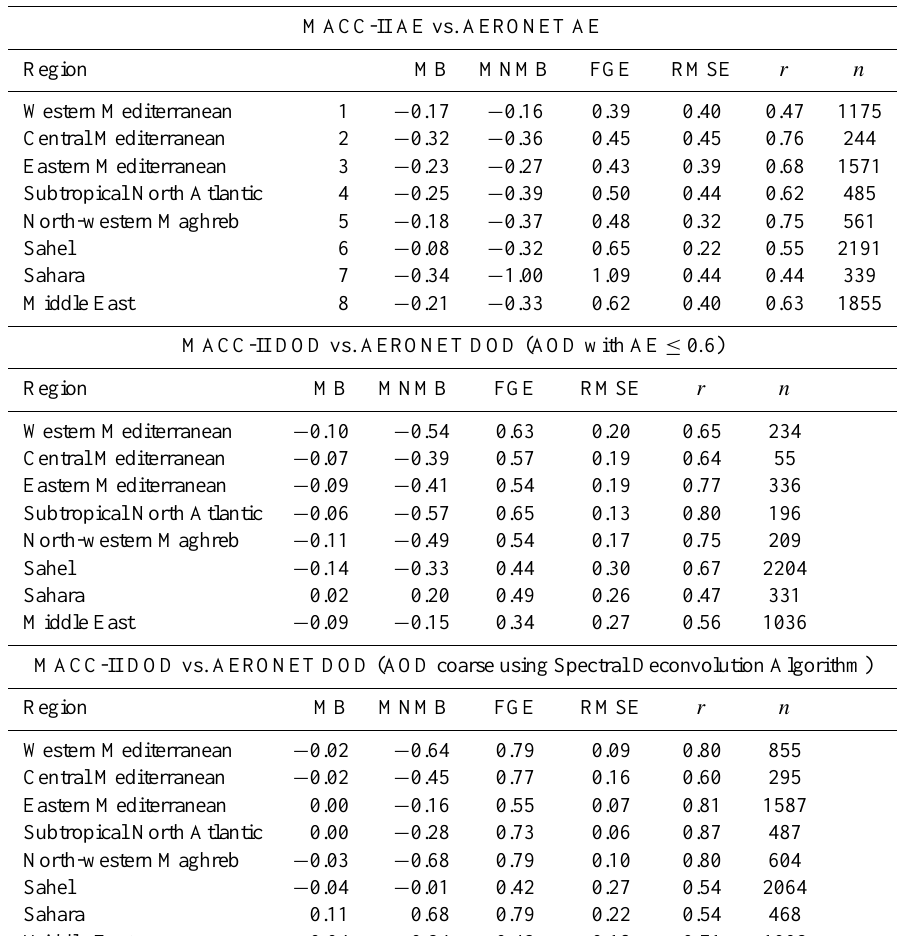
Table 2. Skill scores quantifying the level of agreement between MACC-II and AERONET AE and DOD (obtained from direct-sun and AODcoarse from the SDA retrievals) daily means, obtained by